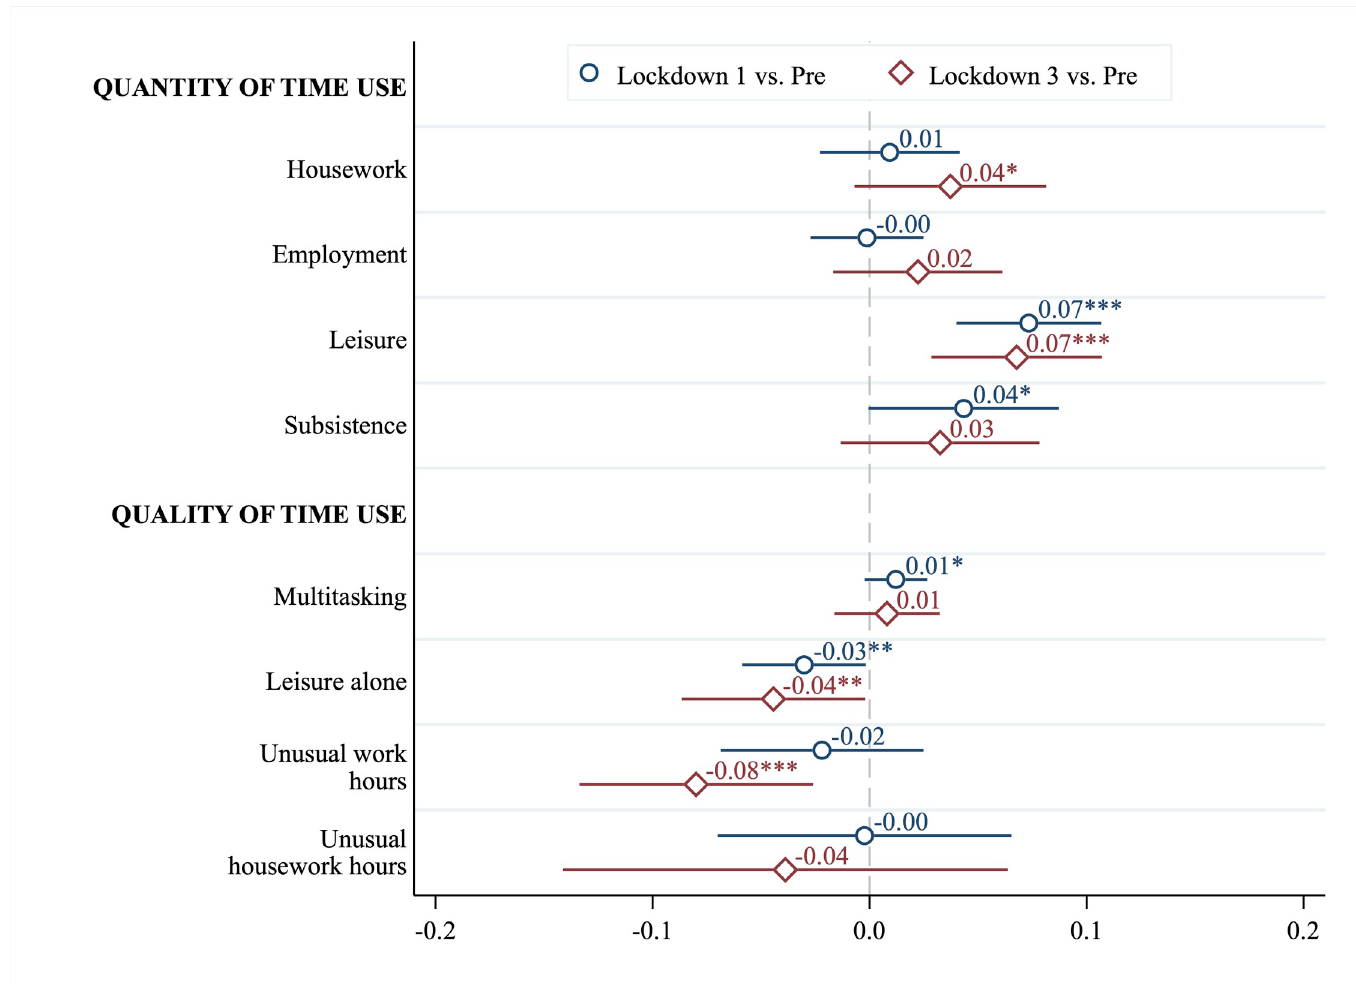
Fig 5. Relationship between changes in enjoyment, quantity of time use, and quality of time use. Estimates of correlations between within-person changes in overall self-reported enjoyment and characteristics of time use. Reported changes during the first and third lockdown (May 2020 and March 2021, respectively) are relative to the pre-pandemic timepoint (February 2020). Regressions include all individuals in our sample. In addition to the variables reported, we also controlled for a vector of respondent characteristics (see main text), and a binary indicator if changes in time spent on employment was missing. A coefficient of 0.1 corresponds to ~0.13 SD in pre-pandemic enjoyment levels. Point estimates are reported with 95% confidence intervals, using robust standard errors. ��� p < 0.01, �� p < 0.05, � p <